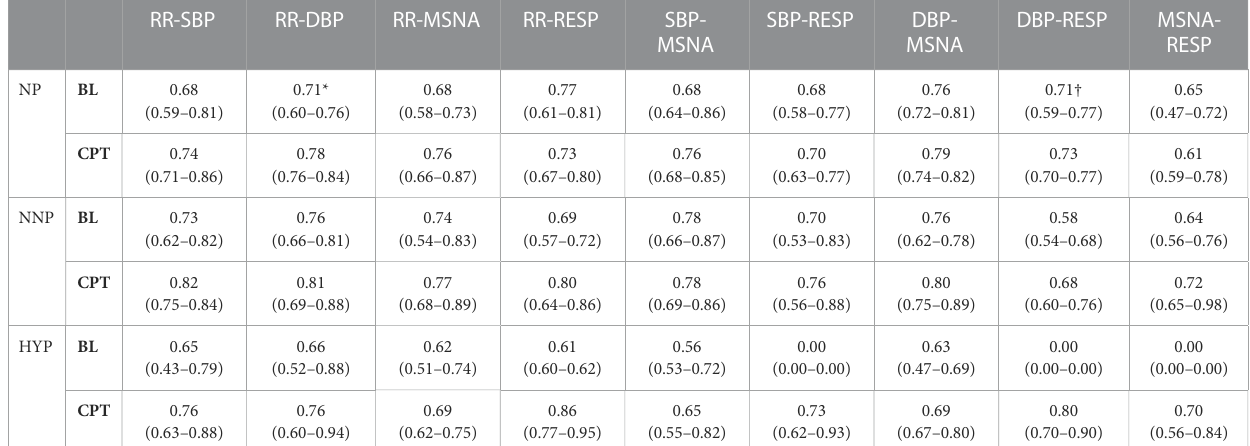
TABLE 3 Wavelet phase coherence results in the low-frequency band. The table shows the results for normotensive non-pregnant women (NNP), normotensive pregnant women (NP), and hypertensive pregnant women (HYP) during baseline (BL) and cold pressor test (CPT) in terms of median and 95% CI. RR: RR interval. DBP:Diastolicbloodpressure.SBP:Systolicbloodpressure.MSNA:Musclesympatheticnerveactivity.RESP:Respiratorywave.*:signi fi cantdifferencewithCPT. † : signi fi cant difference with